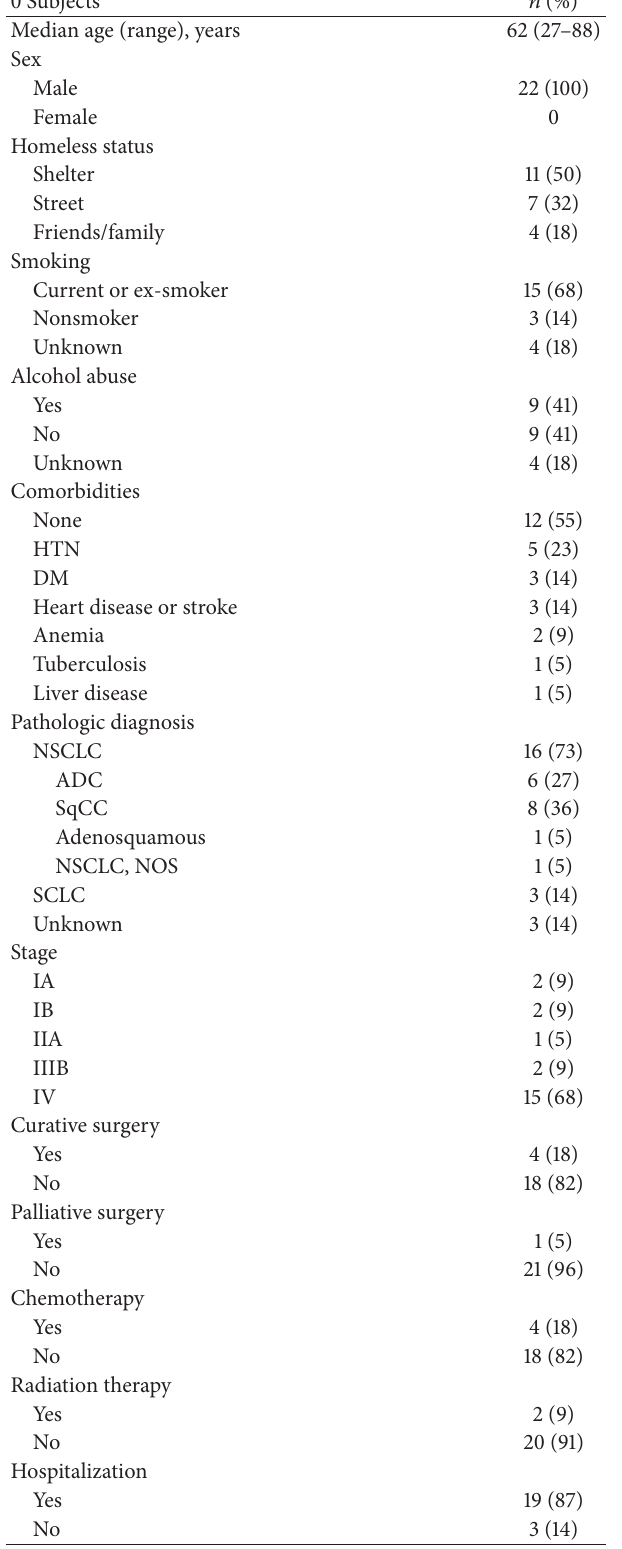
Table 1: Patient characteristics ( 𝑛 = 22